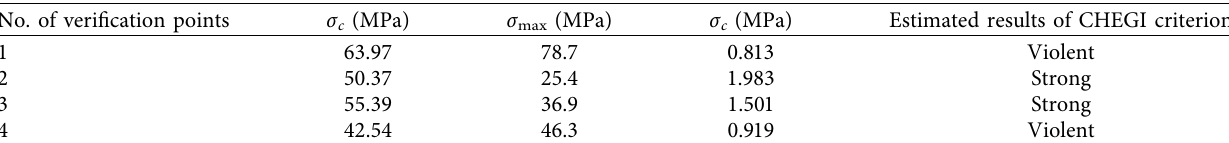
Table 10: Calculation results of σ